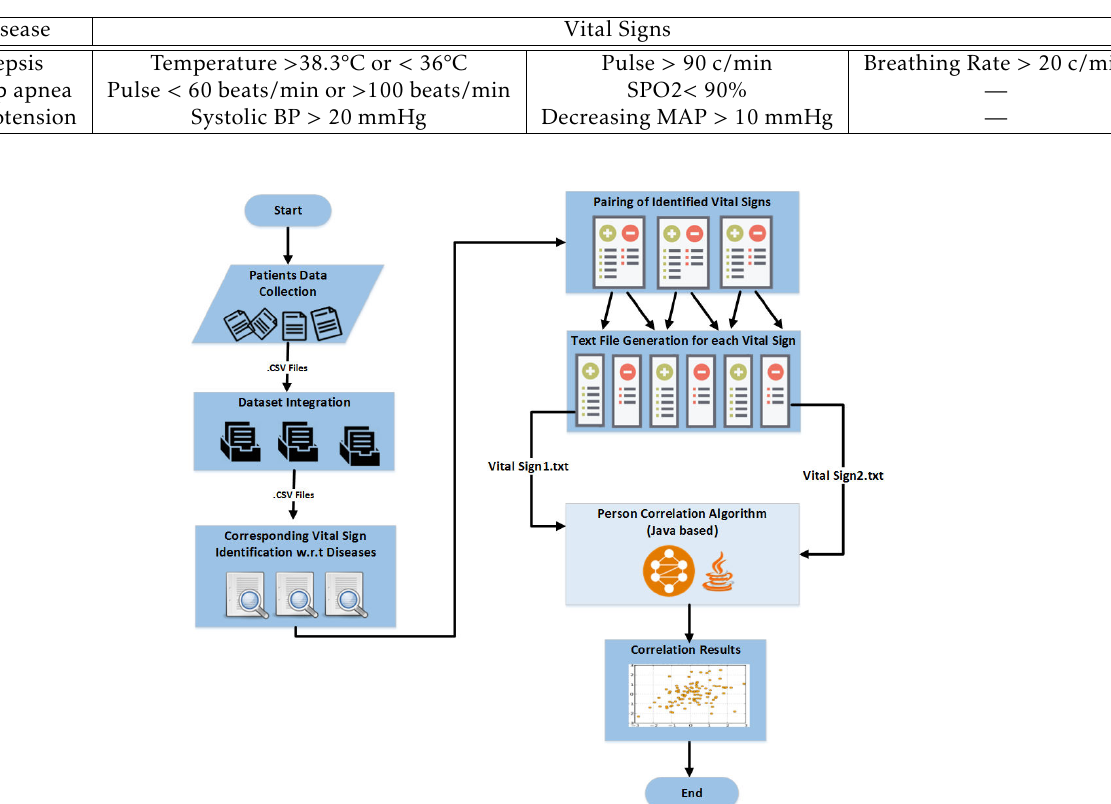
Figure 1. Proposed Work